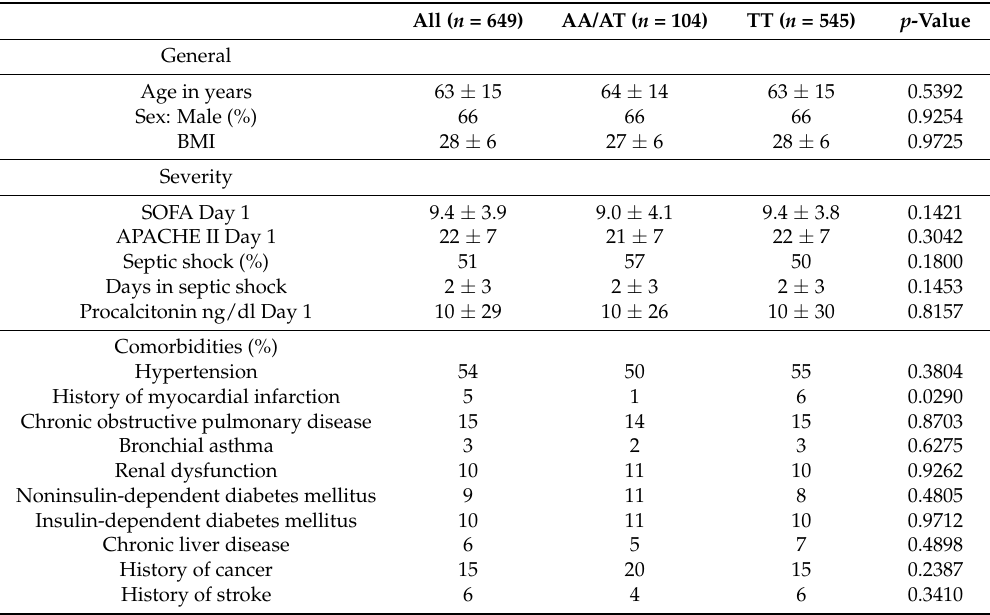
Table 1. Patient baseline characteristics with regard to TREM-1 rs2234237